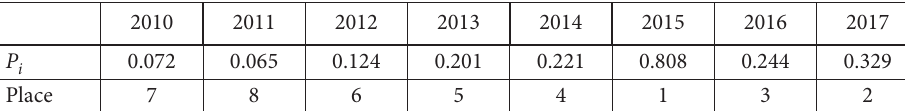
Table 8. Irrational decision making during 2010–2017 (source: authors’